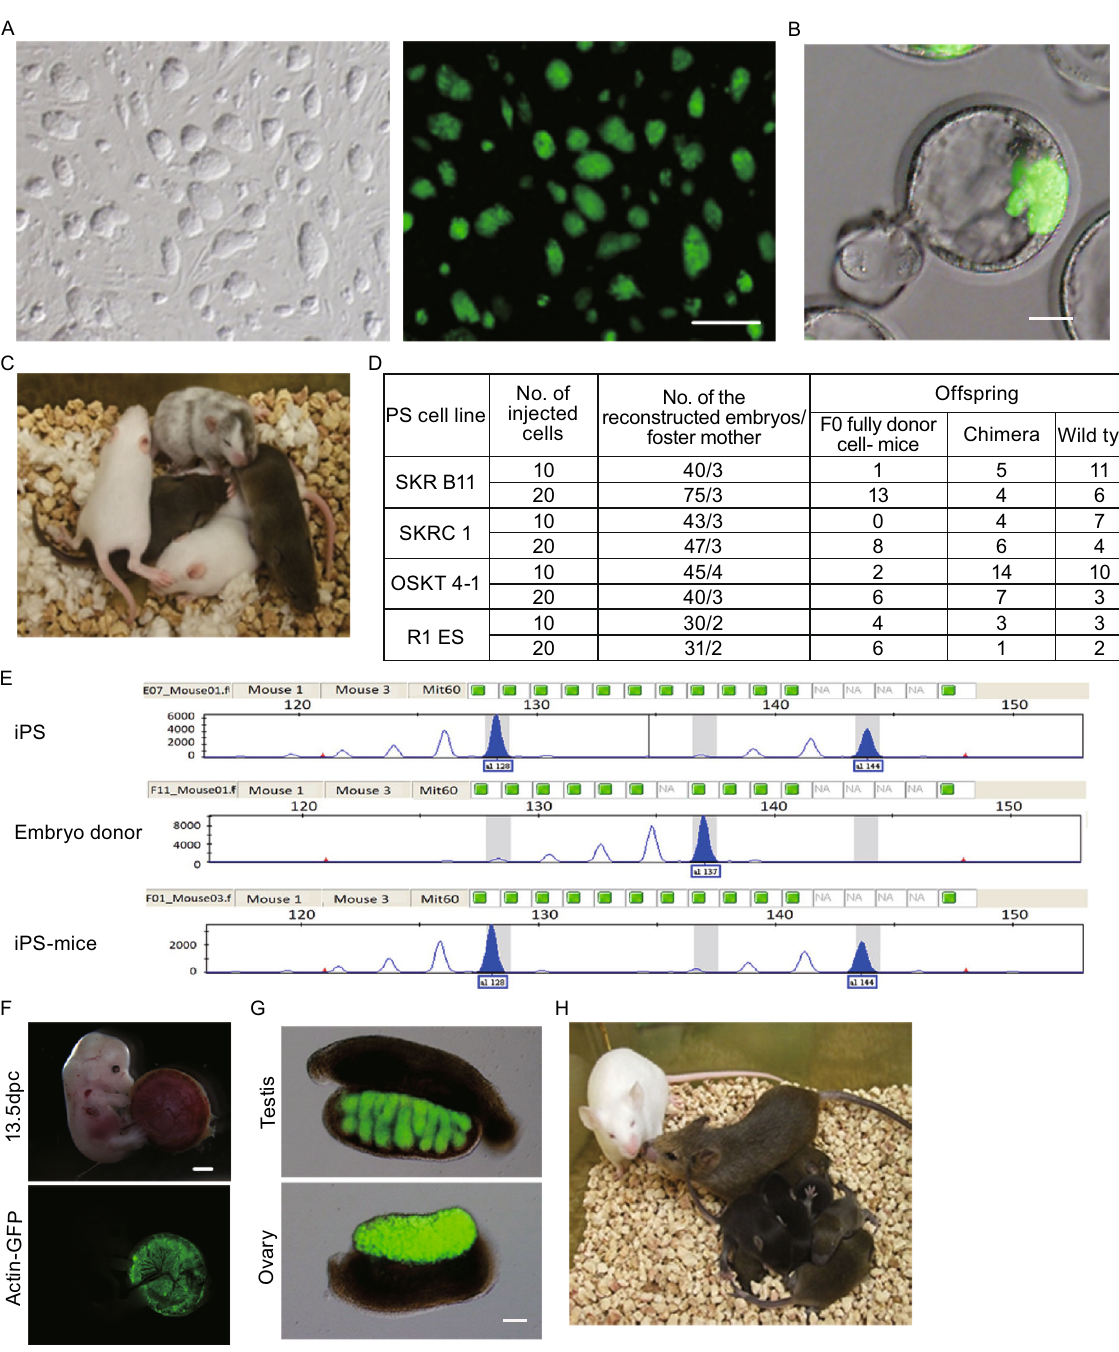
Figure 1. Generation of F0 iPS-mice by 4-cell stage embryo injection. (A) Mouse iPSC colonies (left panel, bright fi eld; right panel, Oct4-GFP). Scale bar, 100 μ m. (B) Blastocyst from 4-cell embryo injection. Scale bar, 20 μ m. (C) F0 generation mice produced by 4 cell-stage embryo injection. (D) Summary of the generation of F0 fully iPSC or ESC-derived mice by 4-cell embryo injection of 20 or 10 donor cells. See also Fig. S1. (E) Representative microsatellite analysis of tails from iPSC-derived mice using D12Mit60 primers. See also Table S1. (F) Chimeric embryo at E13.5 produced by 4-cell stage embryo injection. Scale bar, 1 mm. (G) Gonads of E13.5 embryos from 4-cell embryo injection. Scale bar, 200 μ m. (H) Representative F0 iPSC-derived mouse (agouti color) and